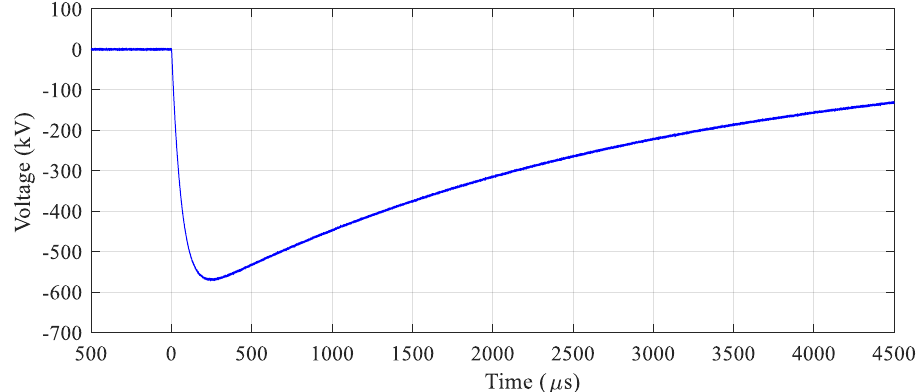
Figure 8. Switching impulse voltage waveform in the Case SI-X3. Table 1. Reference and calculated values, acceptable limits, and deviations of T p